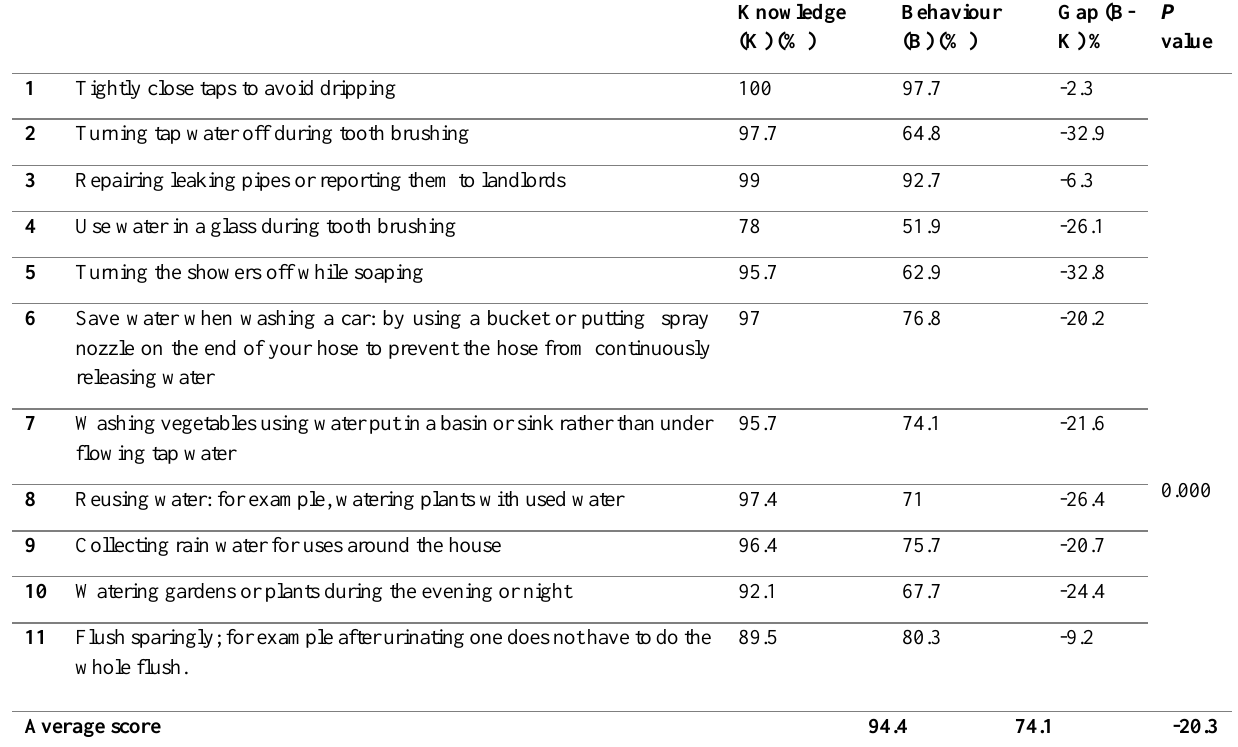
Table 2 : Gap differences between knowledge and behaviour towards water saving technique